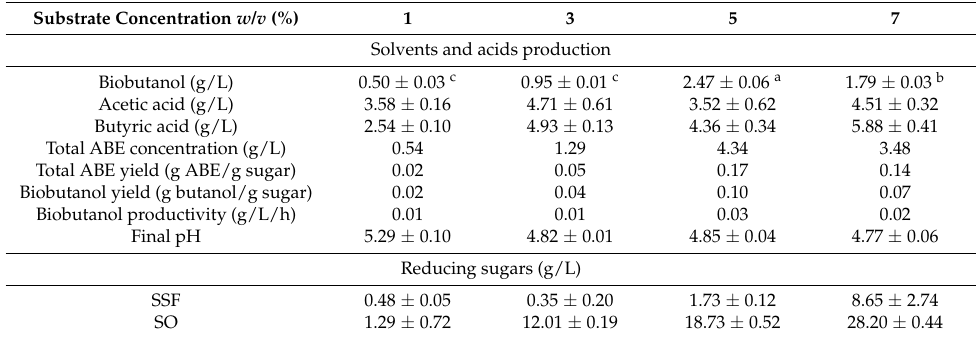
Table 4. Effect of substrate concentrations (1–7% w / v ) on biobutanol production at a temperature of 35 ◦ C, initial of pH 5.5 and cellulase loading of 10 FPU/g-substrate on simultaneous saccharification and fermentation by Clostridium acetobutylicum ATCC